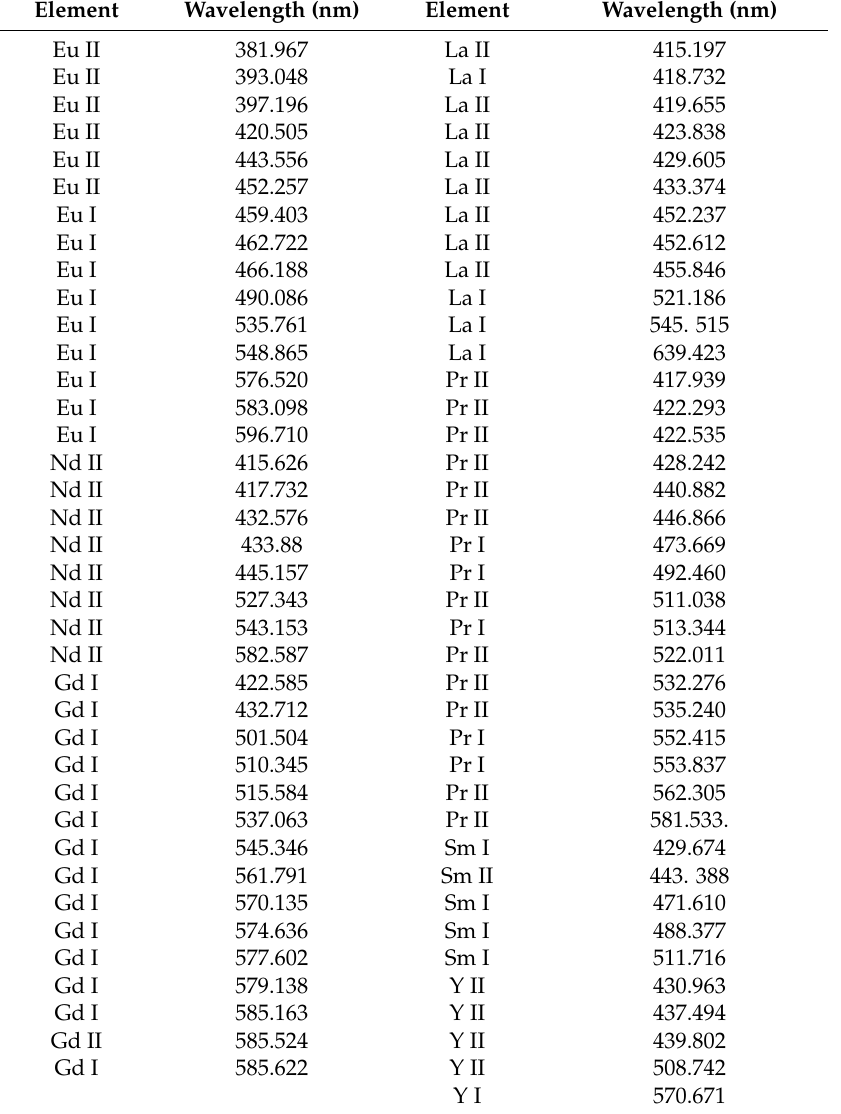
Table 1. Major emission wavelengths contributing to the LIBS spectra for each of the rare earth